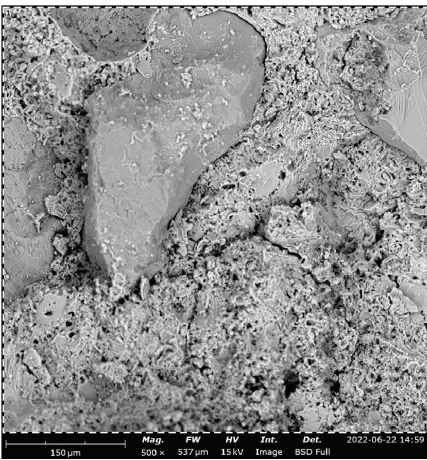
Figure 31: SEM for M2